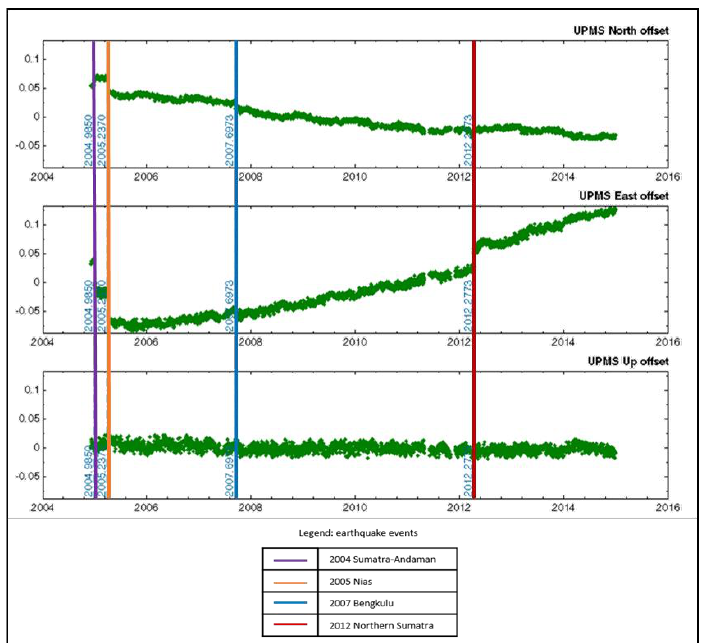
Figure 2. UPMS (University Putra Malaysia) MyRTKnet station time series depicting the 2008-2011 inter-seismic period and co- seismic effects due to earthquakes. UPMS was chosen as it is affected by all the aforementioned nearby earthquakes. Average Velocity (cm/yr) (2008 – 2011) Region VN